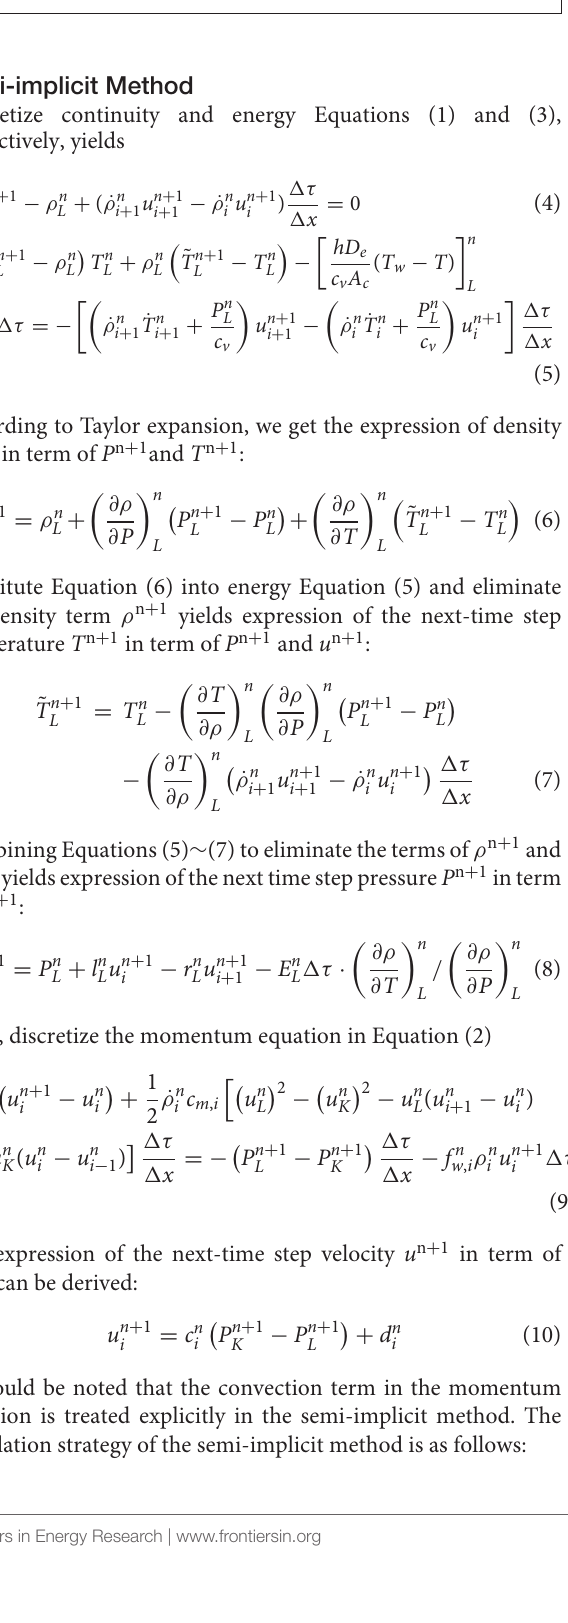
FIGURE 1 | Discritized